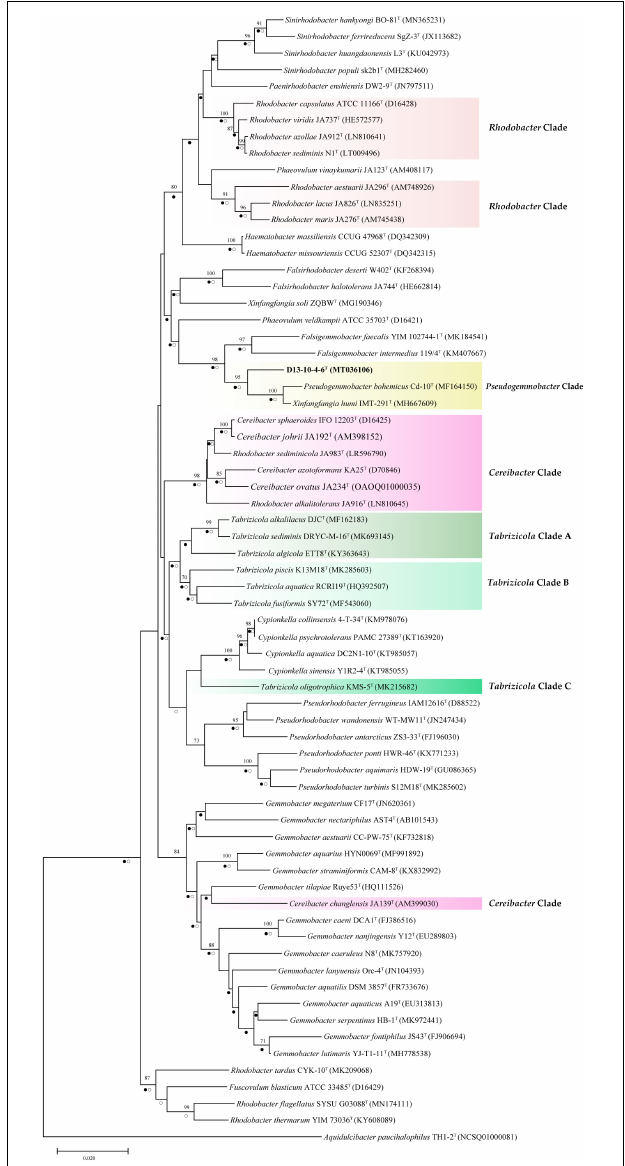
FIGURE 1 | Neighbor-joining tree showing phylogenetic relationships among strain D13-10-4-6 T and reference strains based on 16S rRNA gene sequences. Aquidulcibacter paucihalophilus TH1-2 T was used as an outgroup. Only bootstrap values over 70% (based on 1,000 resamplings) are shown. The scale bar corresponds to 0.01 substitutions per nucleotide site. Filled circles indicate branches recovered by maximum-likelihood method and open circles at branches recovered by the maximum-parsimony